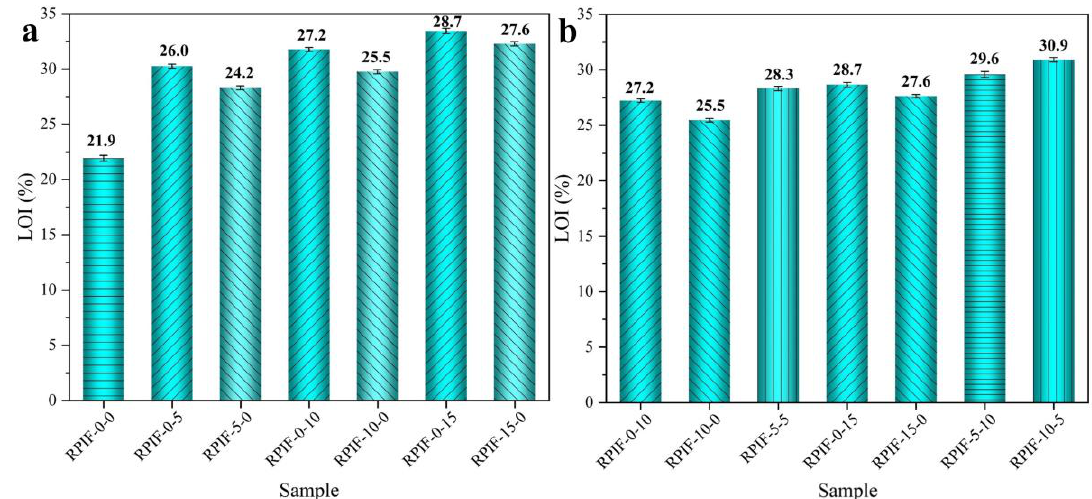
Figure 5. Difference and comparison of effects of PPCP and EG on LOI of RPIF, PPCP or EG alone used ( a ), and combination use of PPCP with EG ( b